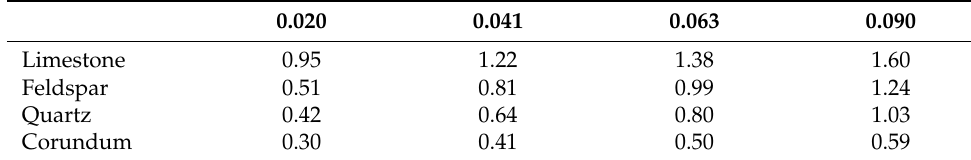
Table 9. Calculated k VTI (SA) (-) indexes according to Equation (9).